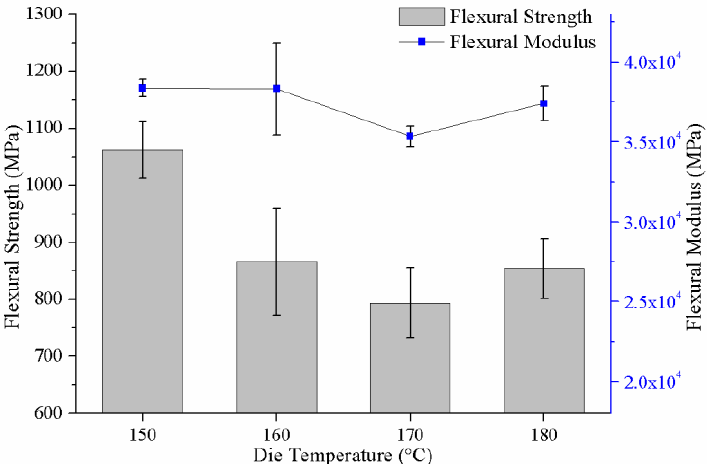
Figure 10. Flexural properties of the pultruded composites depending on the heating zone temperature.